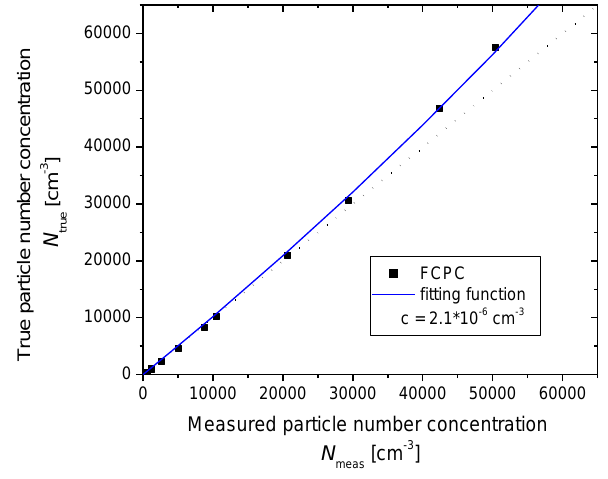
Fig. 4. Measurements of the FCPC and EM at different concentra- tions (squares) as well as a fitted curve according to Eq. (2).